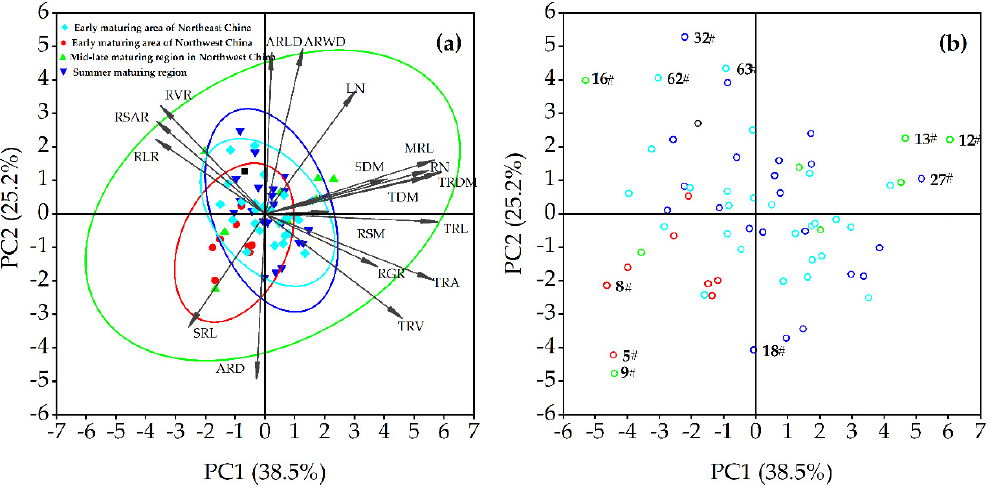
Figure 7. Principal component analysis of root and shoot phenotypes in four ecological regions: ( a ) distribution of 18 selected traits (CVs ≥ 0.2) in principal component 1 and principal component 2 and ( b ) the distribution of 65 genotypes in principal component 1 and principal component 2. Different ecological regions were colored with different colors, respectively.